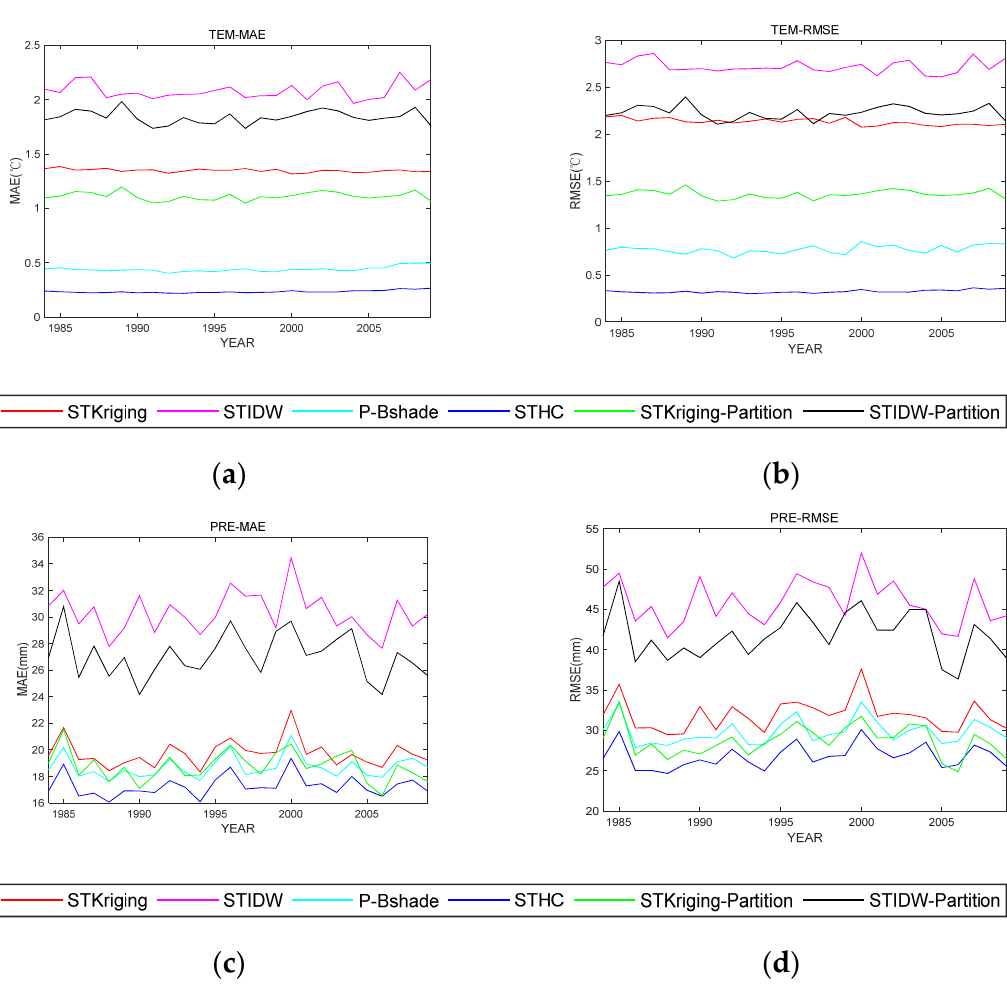
Figure 6. Yearly MAEs and RMSEs from 1984 to 2009 for different methods. ( a ) TEM ‐ MAE; ( b ) TEM ‐ RMSE; ( c ) PRE ‐ MAE; and ( d ) PRE ‐ RMSE.